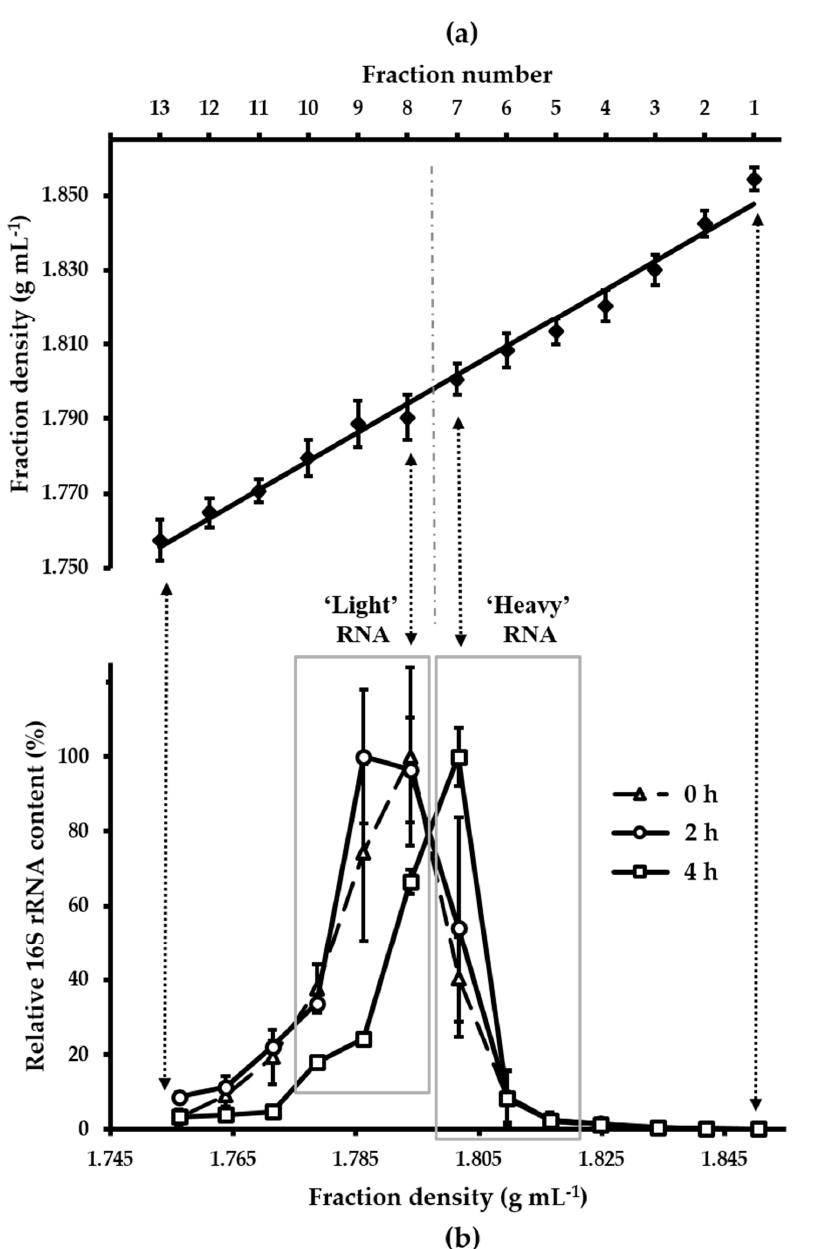
Figure 1. ( a ) Density of isopycnic density gradient fractions. Means and standard errors (SEM) of nine gradients are shown. For each fraction, the SEM was ≤ 0.006 g mL − 1 . The vertical dash dot line divides the density gradient into ‘heavy’ ( ≤ fraction 7) and ‘light’ ( ≥ fraction 8) fractions; ( b ) Distribution of relative amounts of 16S rRNA. RNA from the isopycnic density gradients was collected before (0 h) or after administration of [U 13 C] starch (2 h and 4 h). Means and SEMs of three technical replicates for each gradient fraction per sampling time are shown. To facilitate comparison between the different gradients, RNA content is calculated as a proportion (%) of the fraction containing the highest RNA concentration (100%) per gradient [32]. Boxes indicate ‘heavy’ and ‘light’ density fractions analyzed for microbiota composition. Vertical arrows indicate corresponding fraction numbers in ( a , b ).